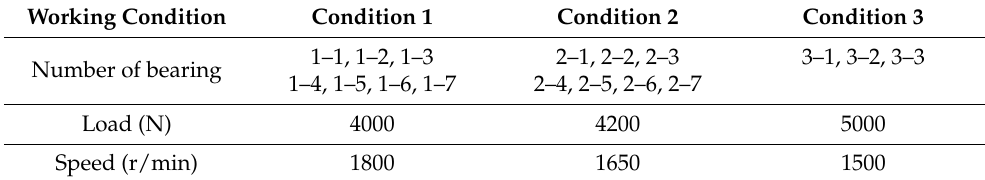
Table 1. PHM2012 data presentation.